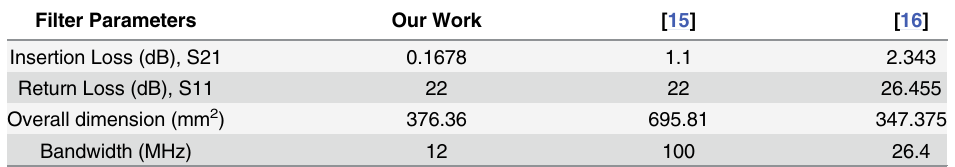
Table 3. Comparasion of the Proposed BPF for Wireless System with [15] and [16] at Same Center